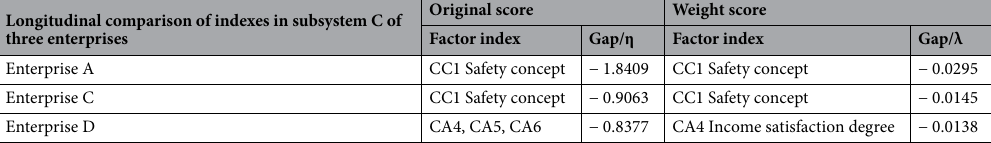
Longitudinal comparison of indexes in subsystem C of three